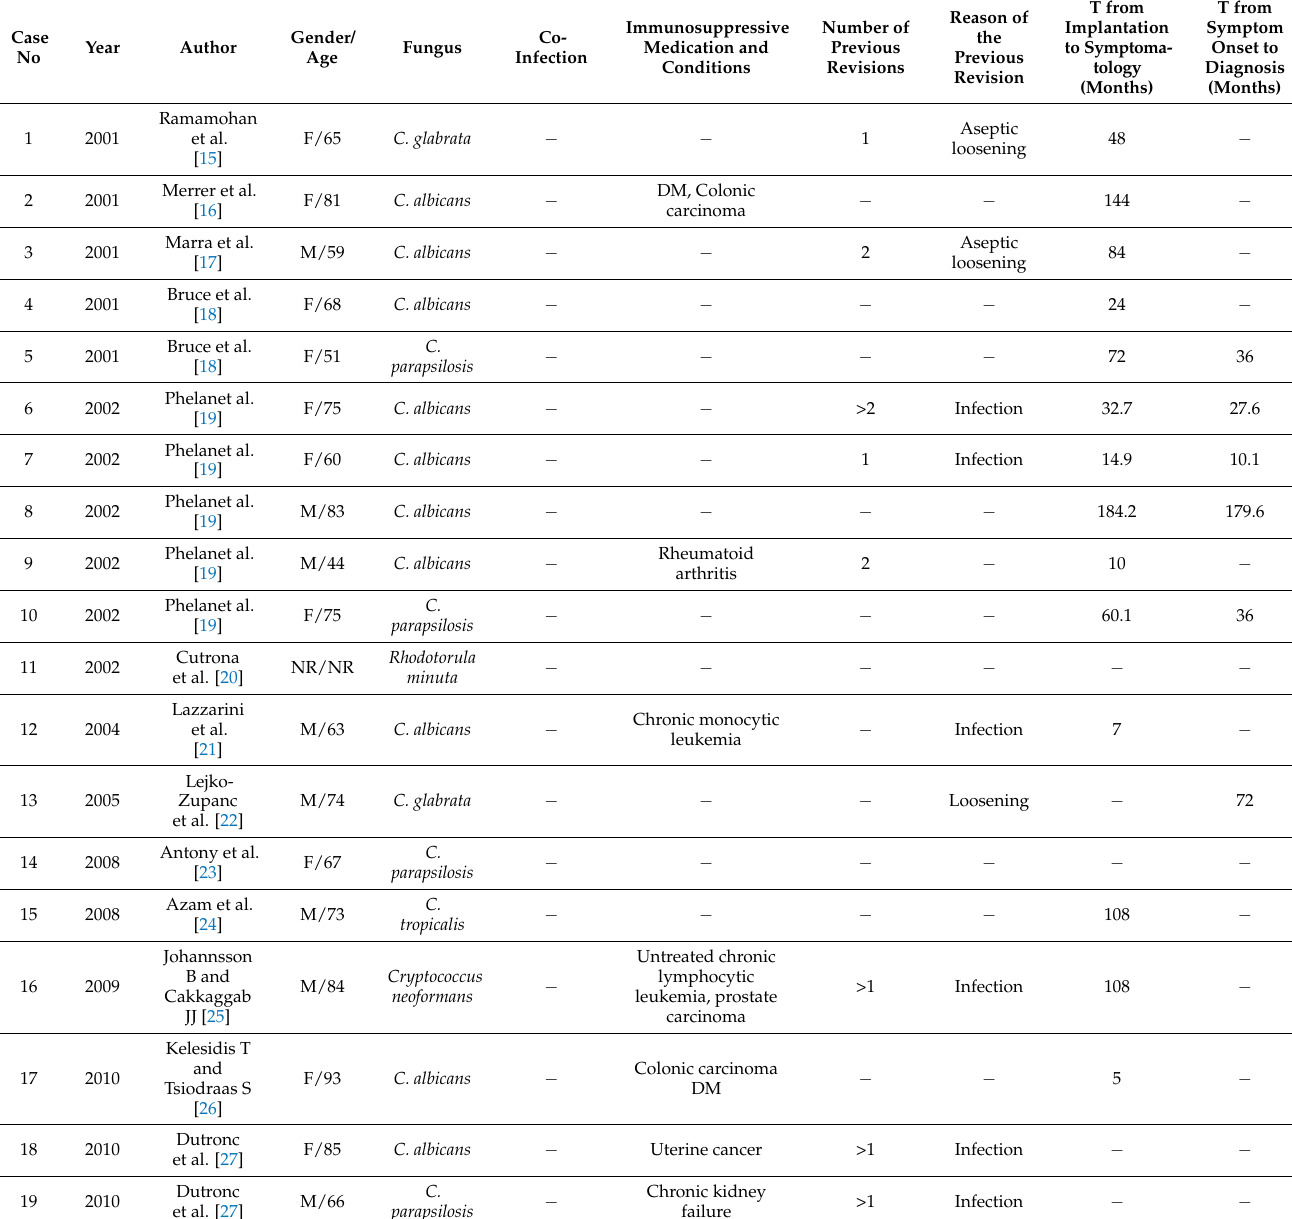
Table 1. Patients’ demographics, causative fungus, bacterial co-infection, comorbidities, number of previous revisions in the same joint, reason of the previous revision, time (T) interval from joint implantation to symptom onset and from symptom to diagnosis are presented. COPD: chronic obstructive pulmonary disease, SLE: systemic lupus erythematosus, DM: diabetes mellitus, ( − ): not mentioned in the original